Question: Summarize what this figure shows in one sentence.
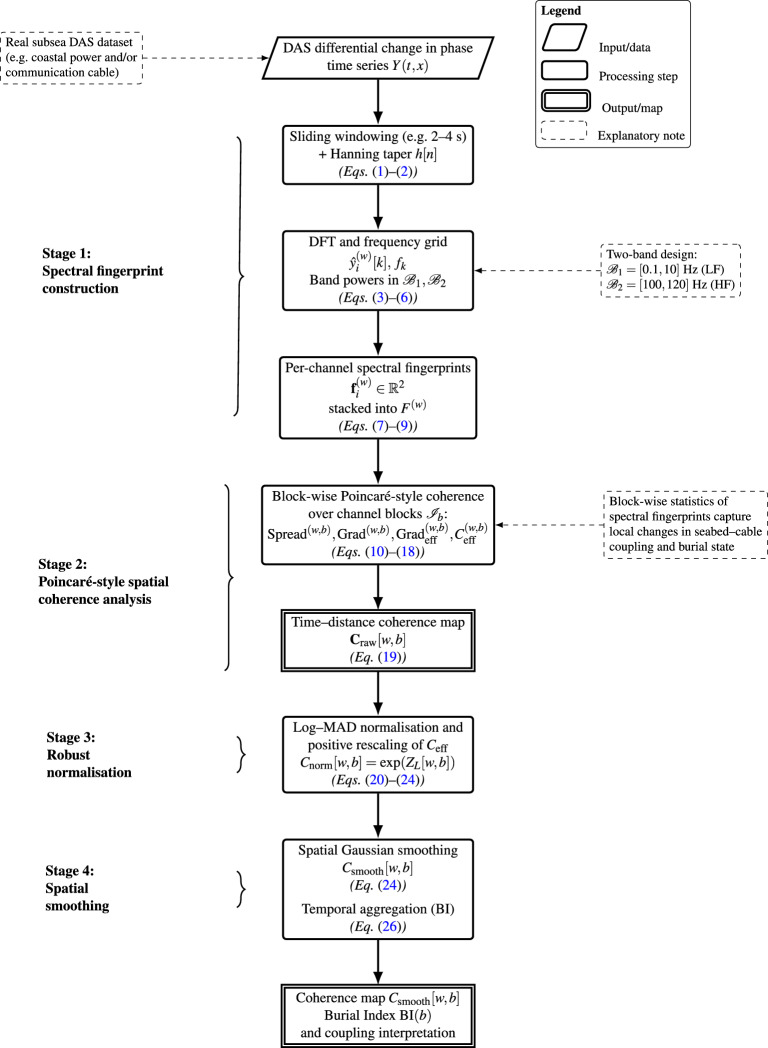
Answer: Workflow of the spectral fingerprint and Poincaré-style coherence framework for DAS data. Stage 1: windowing, tapering, and frequency-domain transformation to form two-band spectral fingerprints. Stage 2: block-wise Poincaré statistics yielding the coherence index \documentclass[12pt]{minimal} \usepackage{amsmath} \usepackage{wasysym} \usepackage{amsfonts} \usepackage{amssymb} \usepackage{amsbsy} \usepackage{mathrsfs} \usepackage{upgreek} \setlength{\oddsidemargin}{-69pt} \begin{document}$$C_{\textrm{eff}}^{(w,b)}$$\end{document} and a time–distance map. Stage 3: log–median–absolute–deviation (MAD) normalisation and rescaling. Stage 4: Spatial smoothing to derive \documentclass[12pt]{minimal} \usepackage{amsmath} \usepackage{wasysym} \usepackage{amsfonts} \usepackage{amssymb} \usepackage{amsbsy} \usepackage{mathrsfs} \usepackage{upgreek} \setlength{\oddsidemargin}{-69pt} \begin{document}$$C_{\textrm{smooth}}$$\end{document} and BI for burial-state identification.